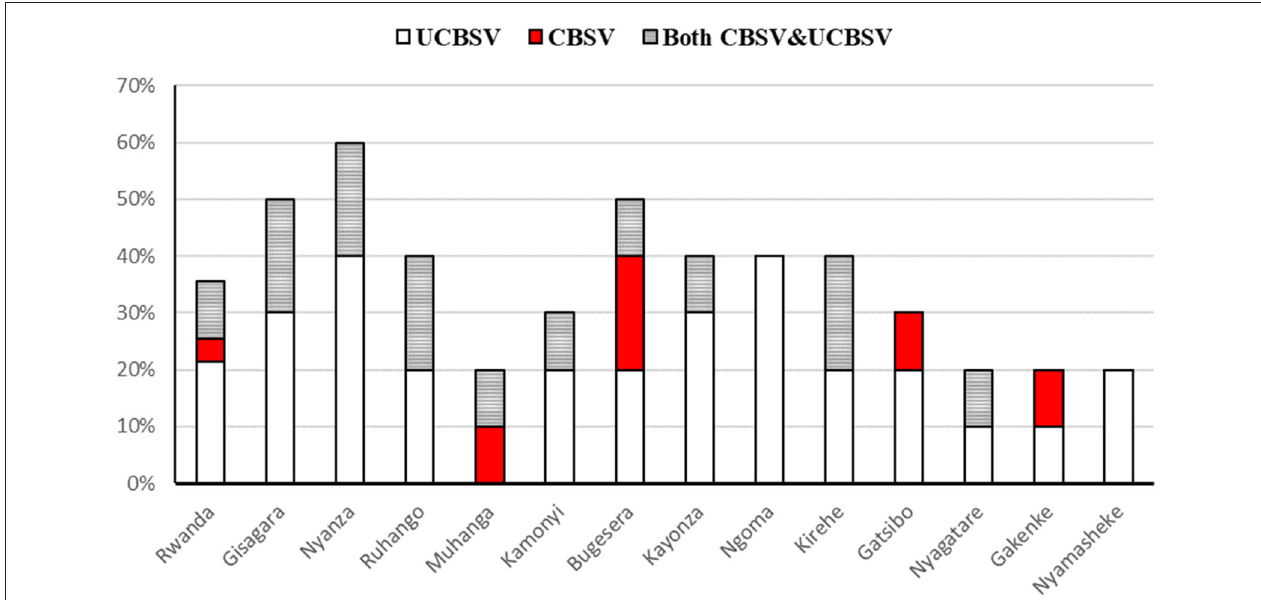
FIGURE 3 | Incidence of CBSD based on RT-PCR in different districts of Rwanda, 2019. The highest incidence was recorded from Nyanza, followed by Gisagara and Bugesera districts. UCBSV, Ugandan cassava brown streak virus; CBSV, Cassava brown streak virus.